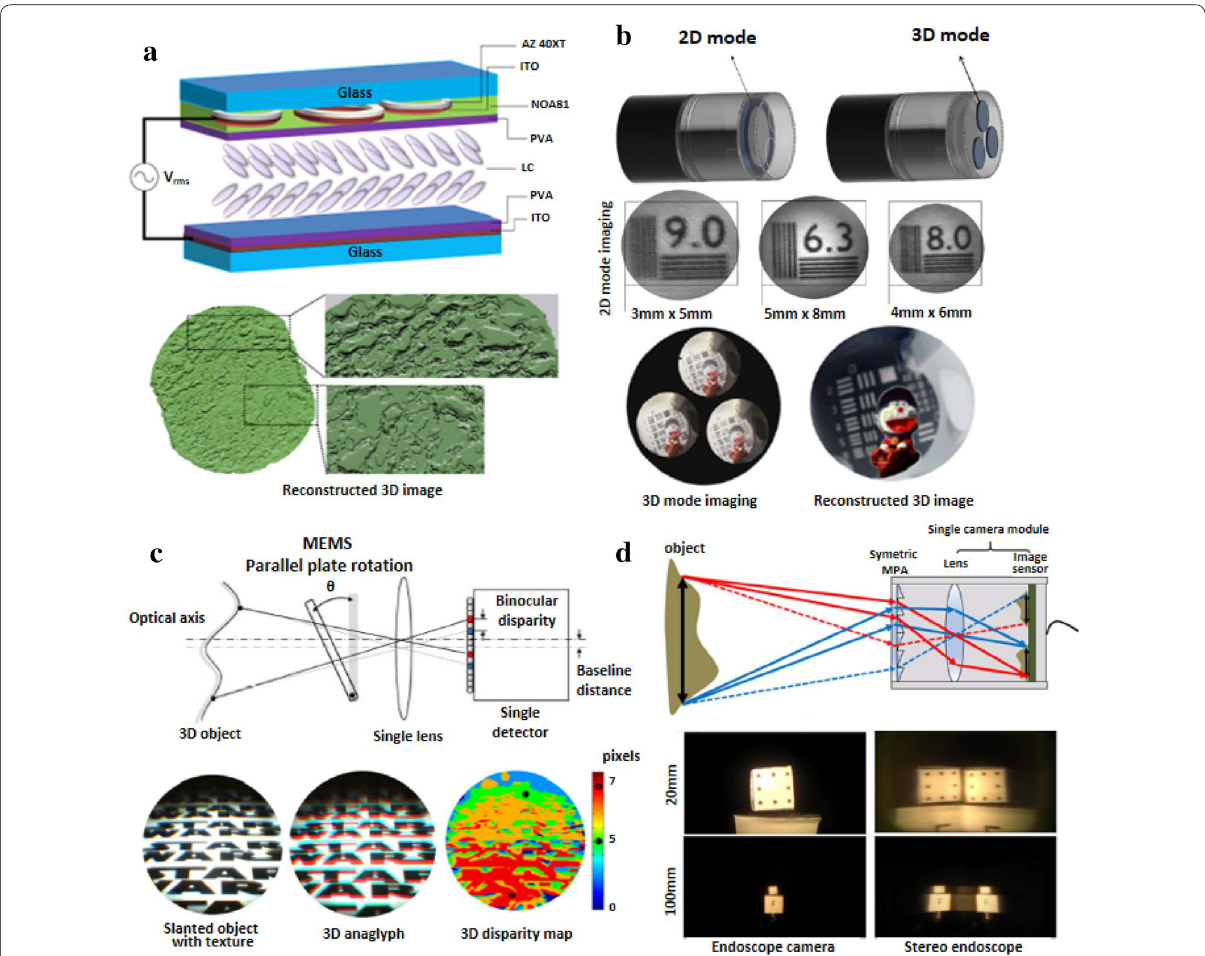
Fig. 2 Single image sensor based optical systems for 3D stereoscopic imaging; a hexagonal LC lens arrays for 3D endoscopy and 3D reconstruction result [27]. b Dual layer electrode LC lens arrays for 2D/3D tunable endoscopy and their 2D/3D mode imaging results [28]. c Electrothermal MEMS parallel plate rotation device and anaglyph image, calculated disparity map of the slanted object with textures [29]. d Microprism arrays based stereo endoscopic camera and stereoscopic imaging result